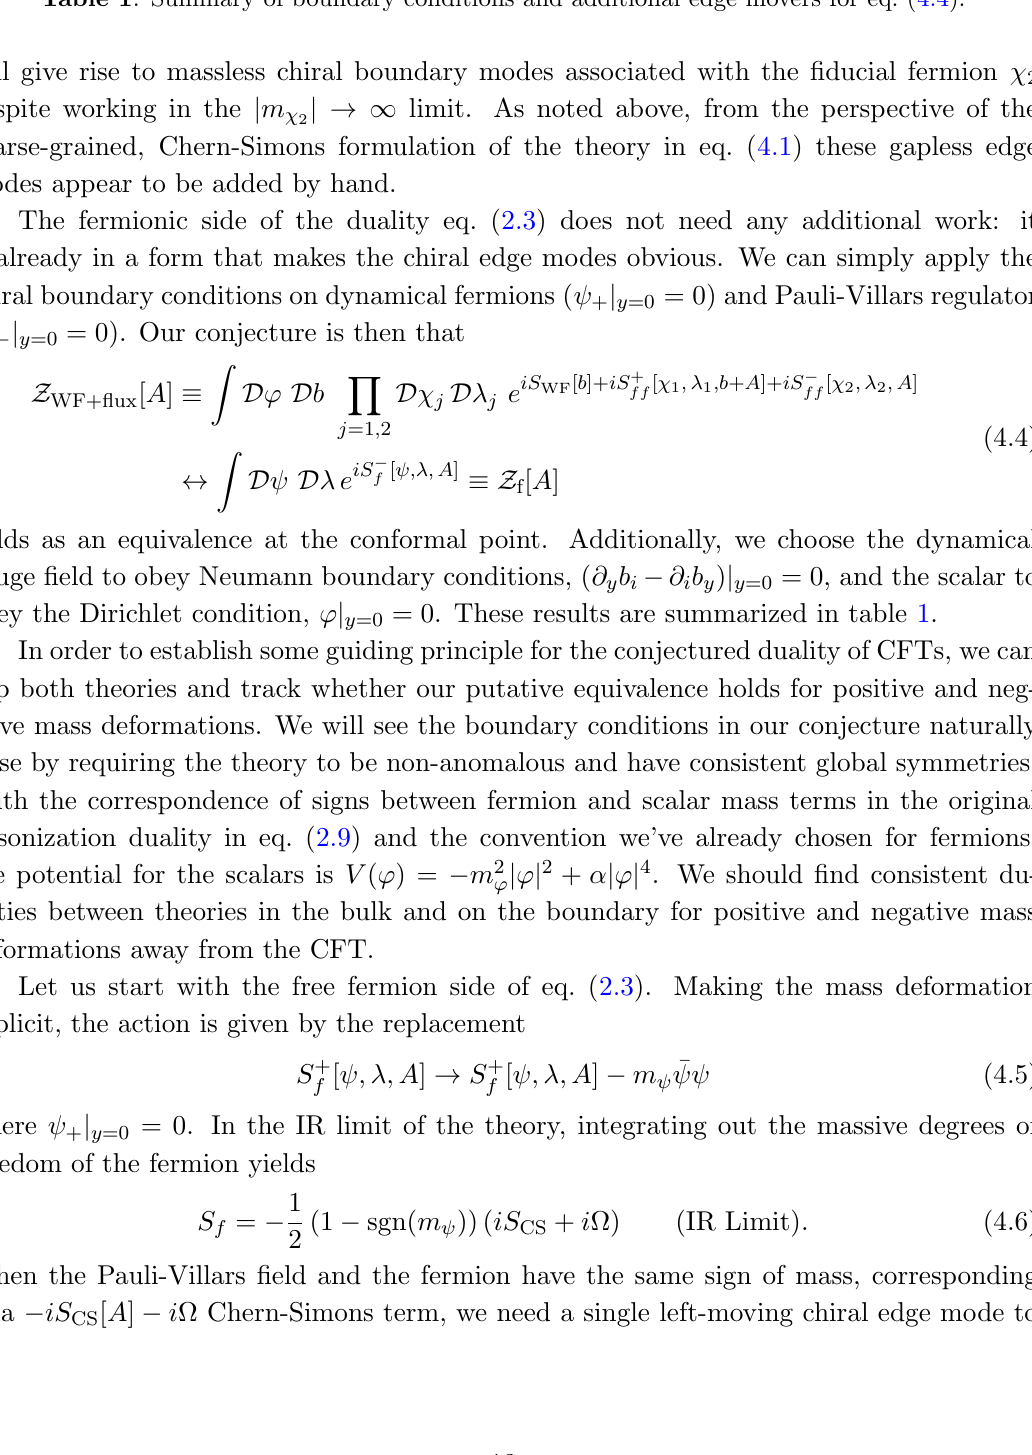
Table 1 . Summary of boundary conditions and additional edge movers for eq.